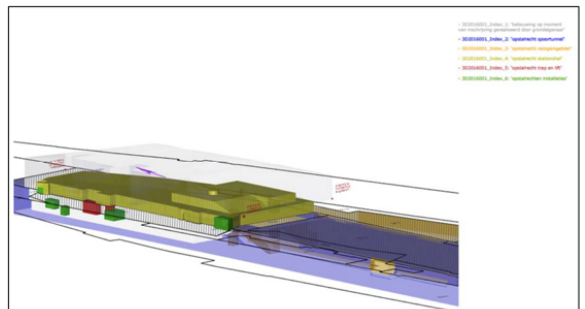
Figure 1: 3D PDF, official document that visualized the multi- level property rights in 3D (case Delft Station) (Stoter et al., 2017).